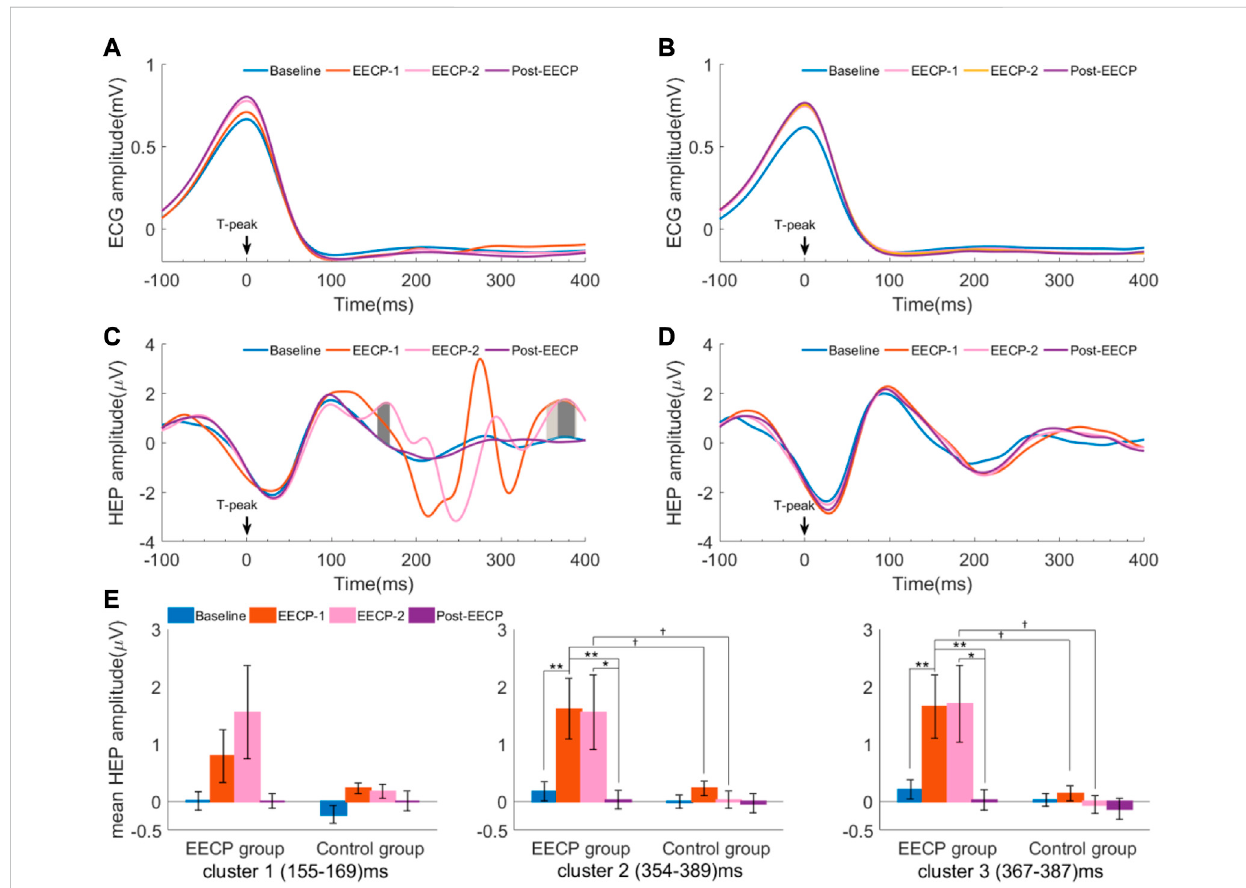
FIGURE 3 Heartbeatevokedpotential(HEP)differencesinBaseline,EECP-1,EECP-2,andPost-EECPperiodsforbothactiveEECPandshamcontrolgroups (A) and (B) are ECG amplitude relative to T-peaks for the active EECP group and sham control group, respectively (C) Three positive clusters with signi fi cant differences in the time windows (155 – 169) ms (deep gray, EECP-2 vs. Baseline), (354 – 389) ms (gray, EECP-1 vs. Baseline), and (367 – 387) ms (deep gray, EECP-2vs.Baseline)afterT-peakwereobservedintheactiveEECPgroup(cluster-basedpermutationtest) (D) Nosigni fi cantdifferenceswerefound in the HEP amplitudes for the sham control group among 4 periods (E) Mean HEP amplitude (values are mean ± SEM) of signi fi cant clusters for active EECP and sham control groups before, during, and after two sessions of 30 minute-EECP. HEP differences were estimated using cluster-based permutation test. p -values for HEP cluster comparisons were tested by two-way repeated measures ANOVA with Bonferroni post hoc analysis. † p < 0.05 (active EECP group compared to sham EECP group); * p < 0.05, ** p < 0.01 (comparison among EECP intervention phases in active EECP